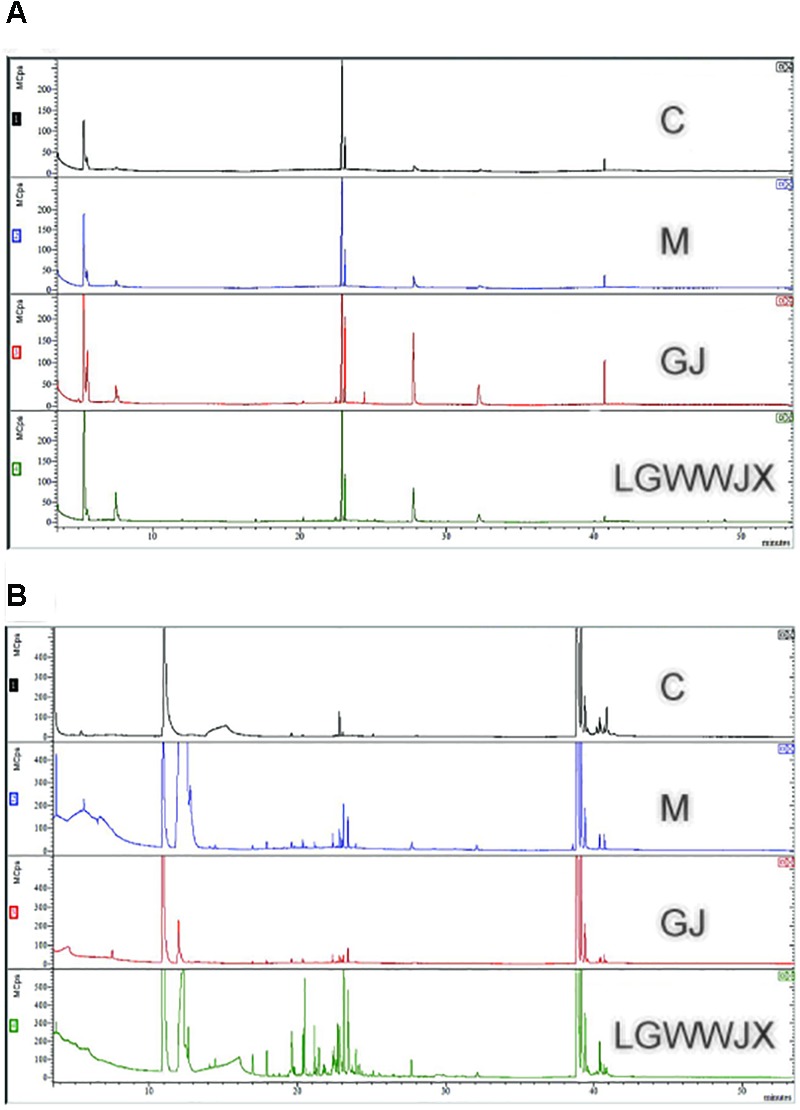
Representative GC–MS TIC chromatograms of control (C), model (M), Gan Jiang (GJ) decoction, and LGWWJX decoction groups in rat serum (A) and urine (B).